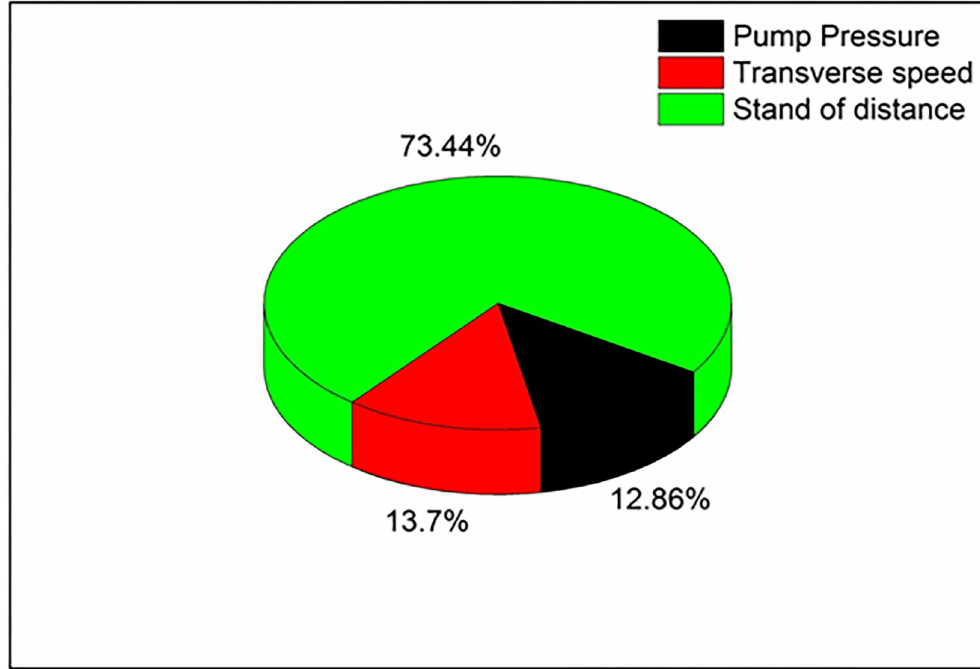
Fig 12. Contribution of machining parameters in 0.1 wt. % filler loaded composite.